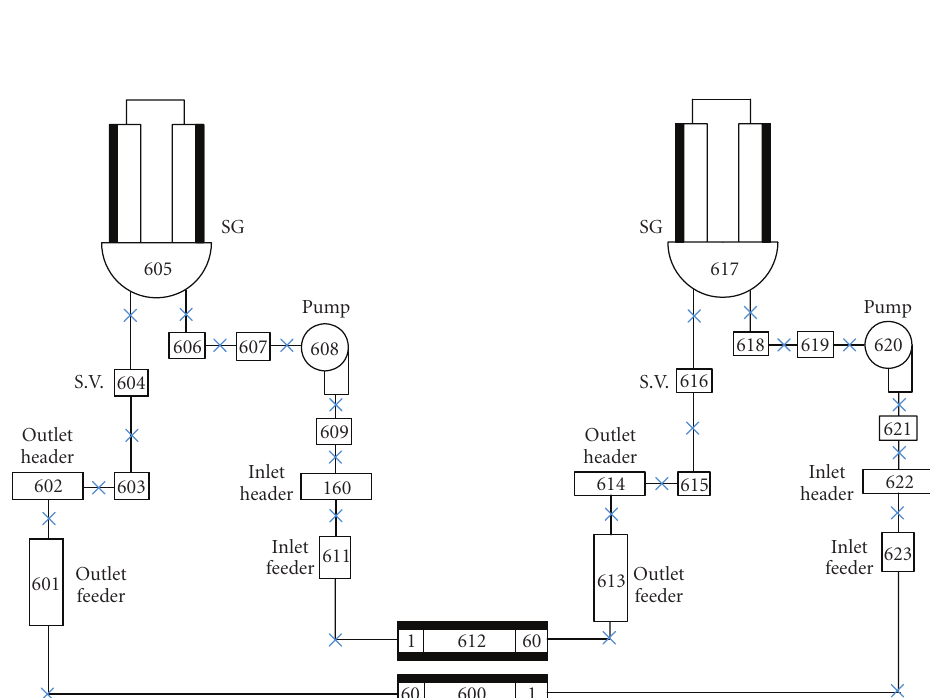
Figure 4: 700 MWe PHWR loop-2